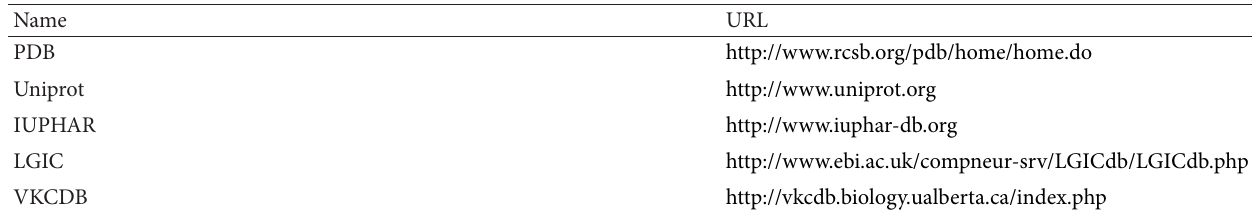
Table 1: List of databases related with ion channels.